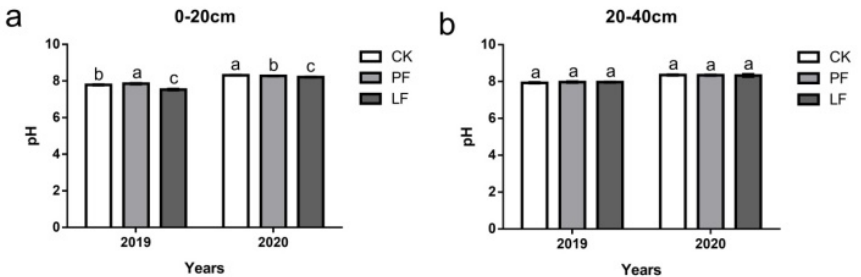
Figure 6. Effects of in-row mulching on the pH of the soil in 2019 and 2020. ( a ): pH (0–20 cm); ( b ): pH (20–40 cm). Different letters above the columns indicate significant differences between treatments in Duncan’s multiple comparisons ( p < 0.05) .